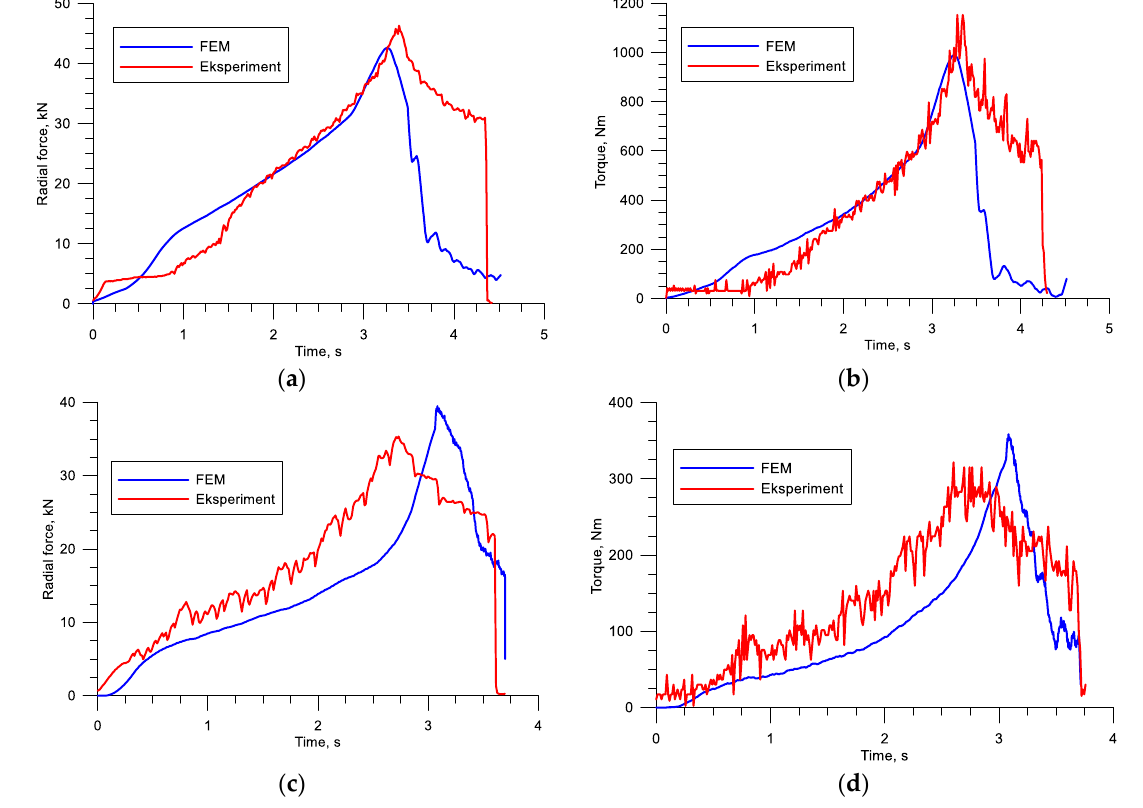
Figure 13. Force parameters in the rotary compression of a hollow stepped gear shaft: ( a ) radial force (Operation 1), ( b ) torque (Operation 1), ( c ) radial force (Operation 2), ( d ) torque (Operation 2).